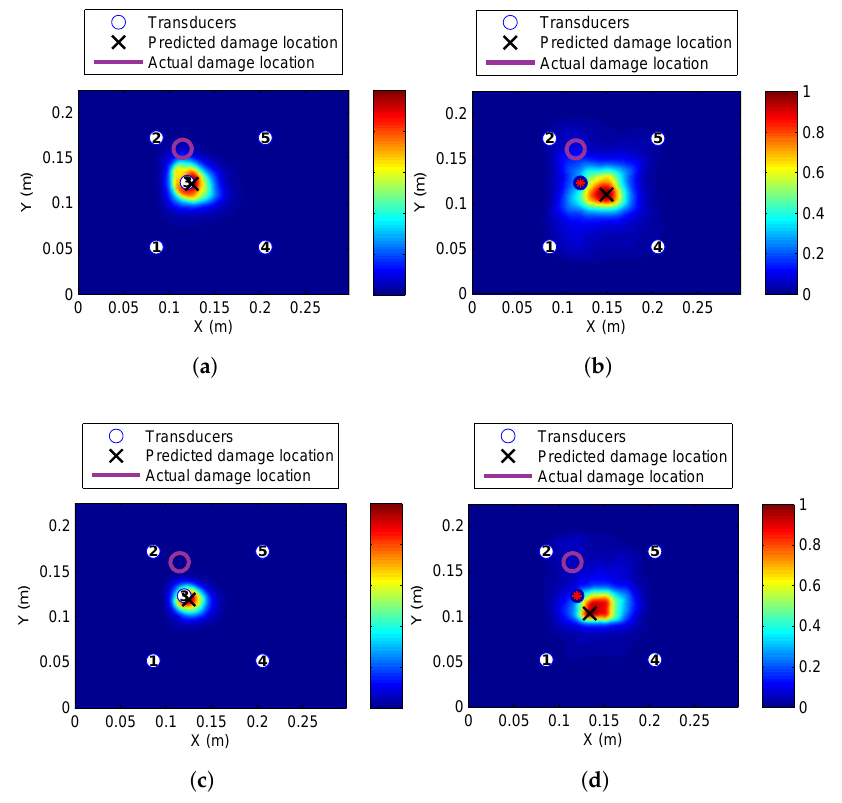
Figure 11. Barely visible impact damage (BVID) impact detection on the SHM layer CFRP plate at 50 kHz, baseline recorded at 25 ◦ C: ( a ) 0 ◦ C, five transducers; ( b ) 0 ◦ C, four transducers; ( c ) 35 ◦ C, five transducers; ( d ) 35 ◦ C, four